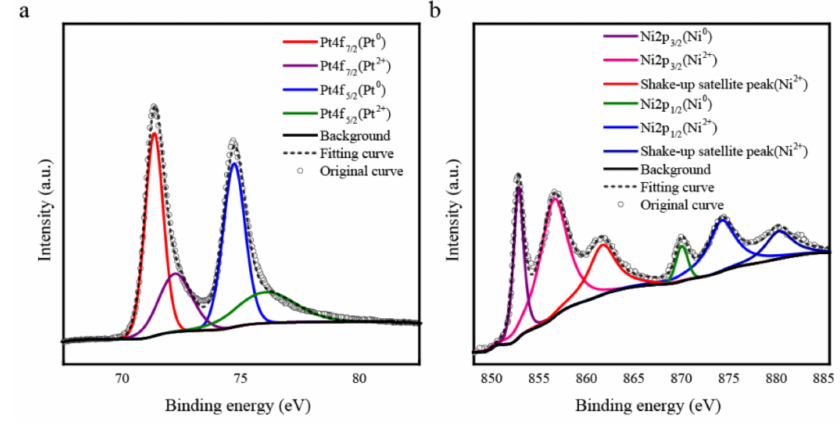
Figure 4. XPS peaks ( a ) Pt 4f and ( b ) Ni 2p of